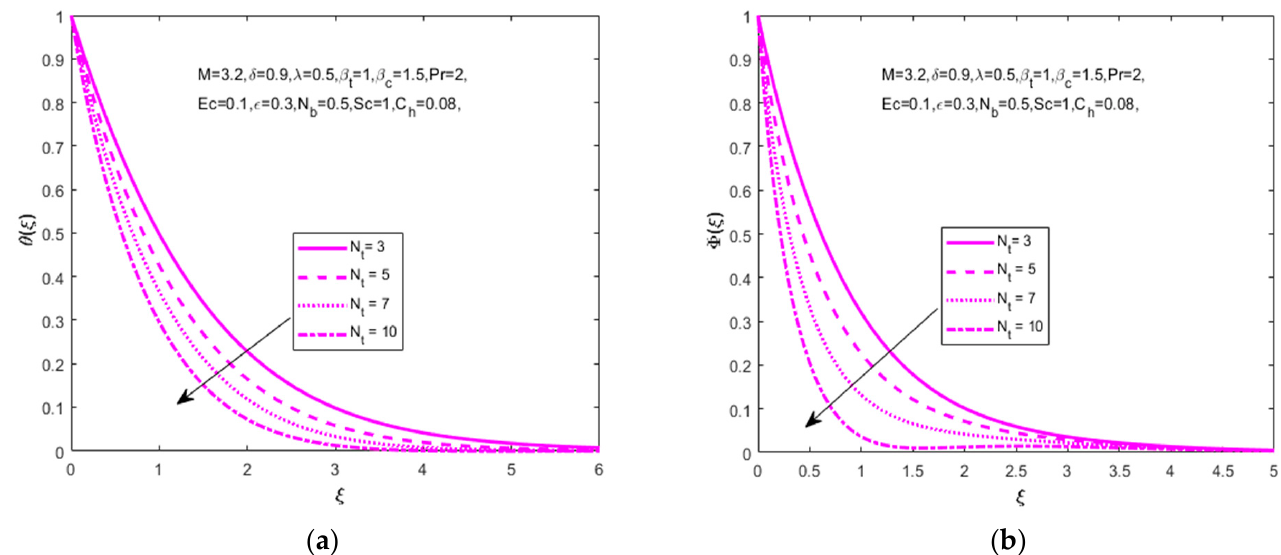
Figure 5. Impact of Brownian motion parameter N b on ( a ) temperature ( θ ( ξ )) and ( b ) concentration Φ ( ξ ) , respectively.